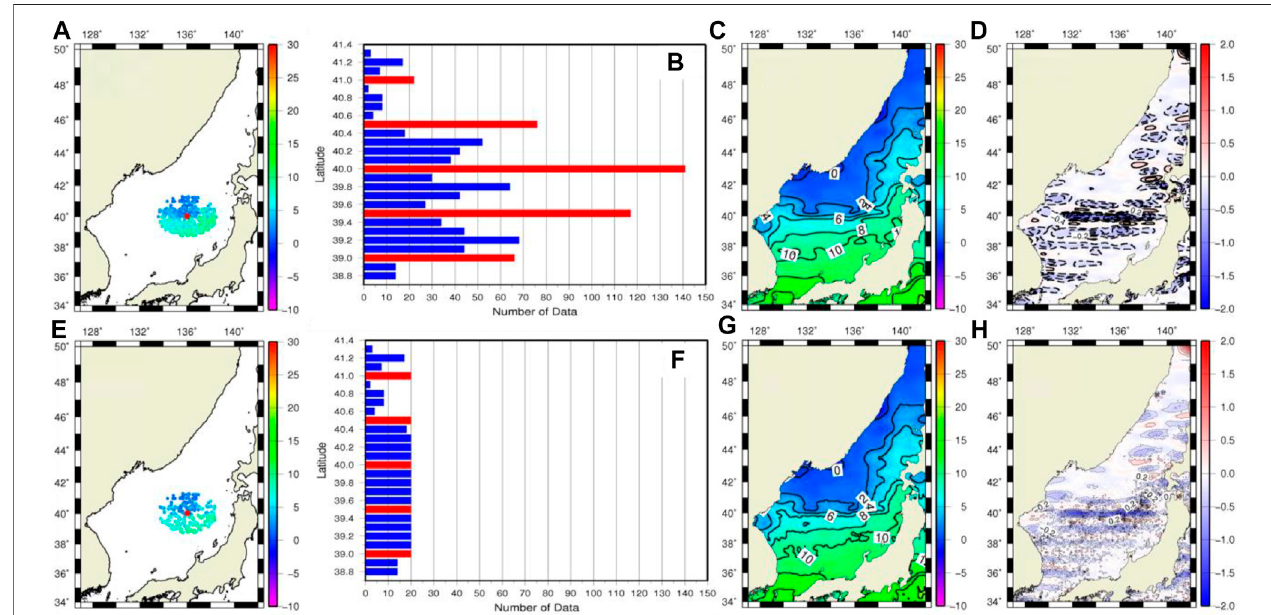
FIGURE5|(A) Datapositionand (B) latitudinalchangeofthenumberofdatawithinthein fl uenceradiusof136 ° E,40 ° N, (C) horizontaltemperaturedistribution,and (D) meridional temperature gradient by using only the irregular WOD13. Bottom panels provide the same information as the upper panels except for reduced WOD13 data that was randomly extracted for up to 20 pro fi les along 0.1 ° each latitudinal band within the in fl uence radius.